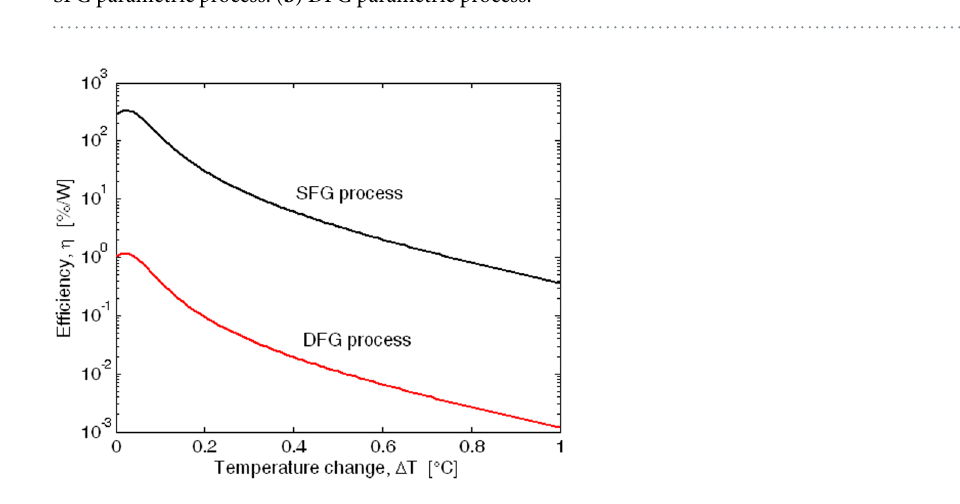
Figure 13. Efficiency η for SFG and DFG processes as a function of the temperature